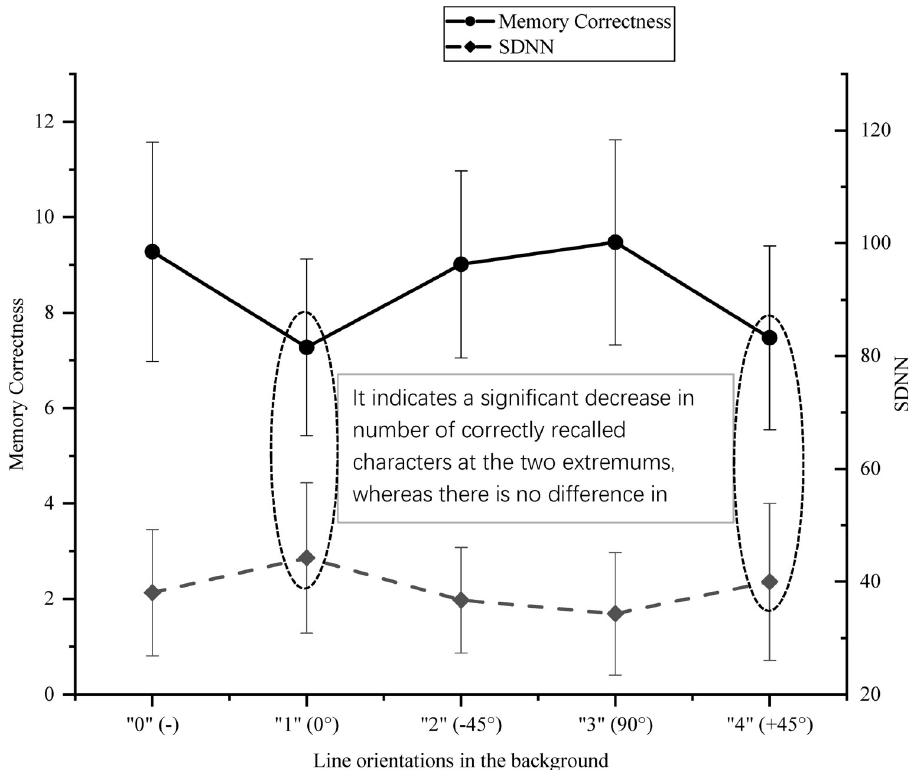
Fig 3. The mean values of correctly memorized foreground characters and users’ SDNN in different background line orientations.